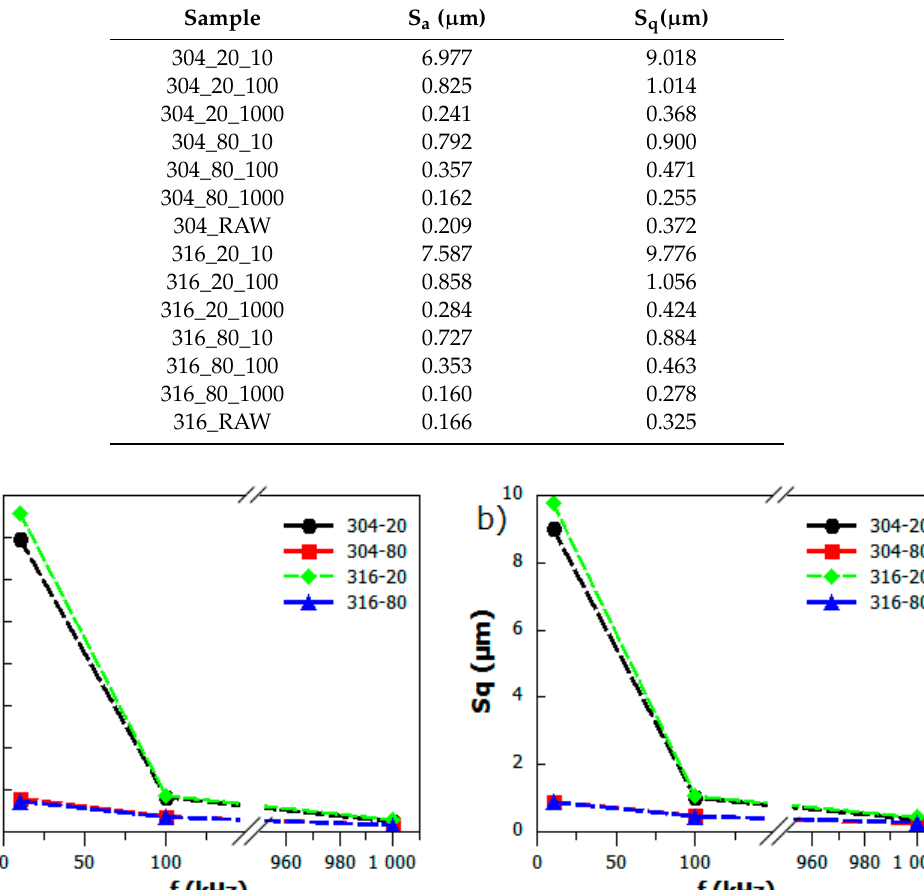
Table 3. The 3D surface roughness parameters S a and S q . The 304_RAW and 316_RAW samples represent the unmodified plates.